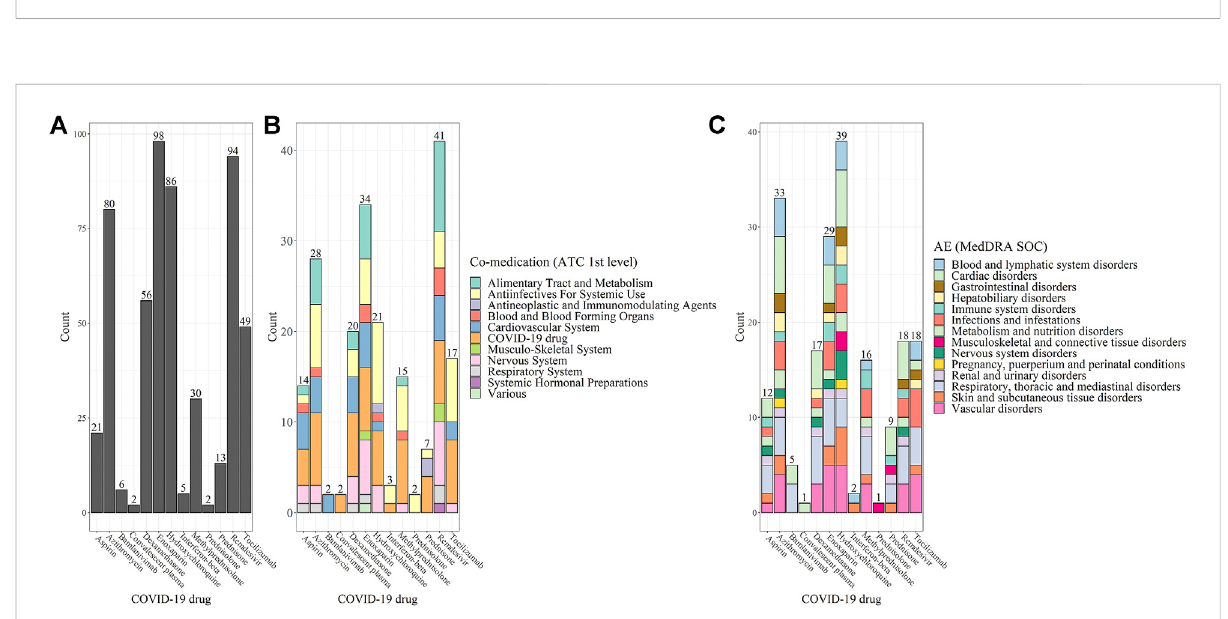
FIGURE 3 (A) The number of signi fi cant DDIs. (B) The number of unique co-medications that caused interactions with the COVID-19 drugs. (C) The number of unique